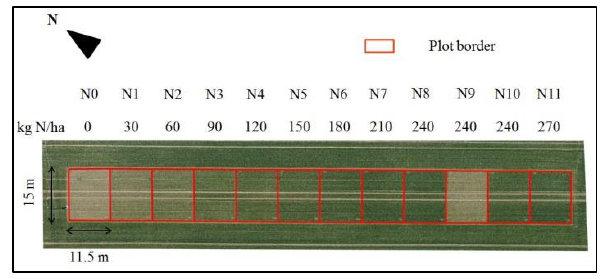
Figure 1. Field experiment with twelve nitrogen (N) treatments